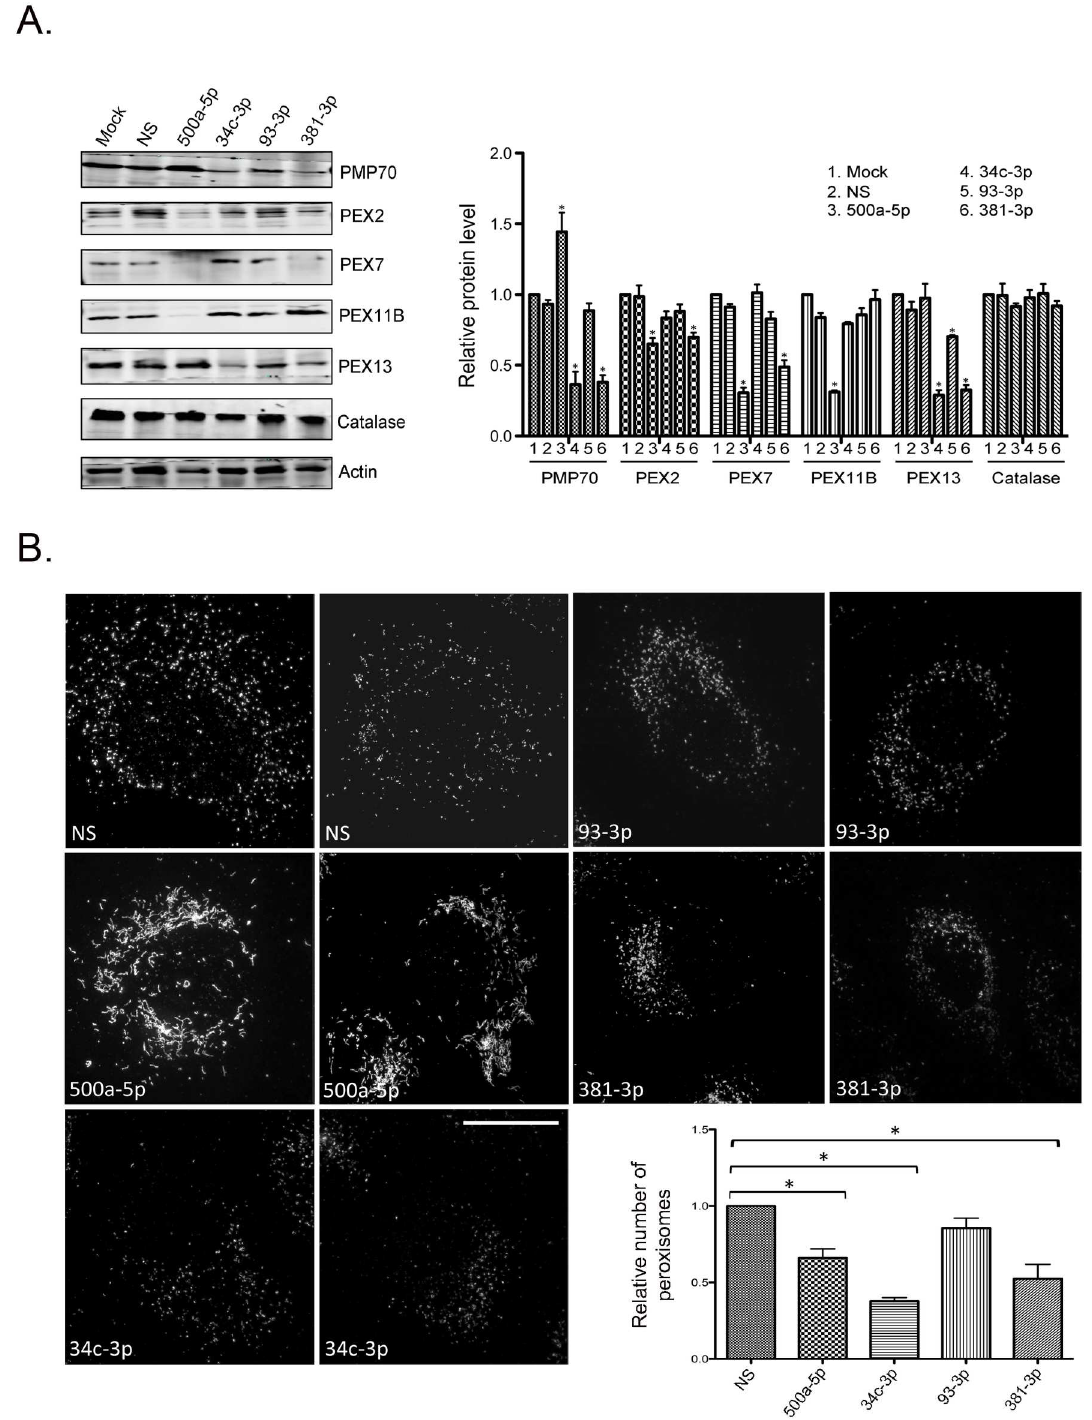
Fig 3. A subset of HAND-associated miRNAs reduces expression of peroxisomal proteins and alters peroxisome abundance and/or morphology. A. A549 cells were transfected with mimics (30 nM) for miR-NS, miR-500a-5p, miR-34c- 3p, miR-93-3p or miR-381-3p.Forty-eight hours later, cell lysates were subjectedto immunoblot analyses. PMP70 and actin were detected using primary mouse monoclonal antibodiesand secondarydonkey anti-mouseIgG conjugated to Alexa Fluor 680. PEX2, PEX7, PEX11B, PEX13 and catalasewere detected using primary rabbit antibodiesand secondarygoat anti- rabbit IgG conjugatedto Alexa Fluor 680. Relativeperoxisomal protein levels (normalized to actin) in mock- and miRNA-